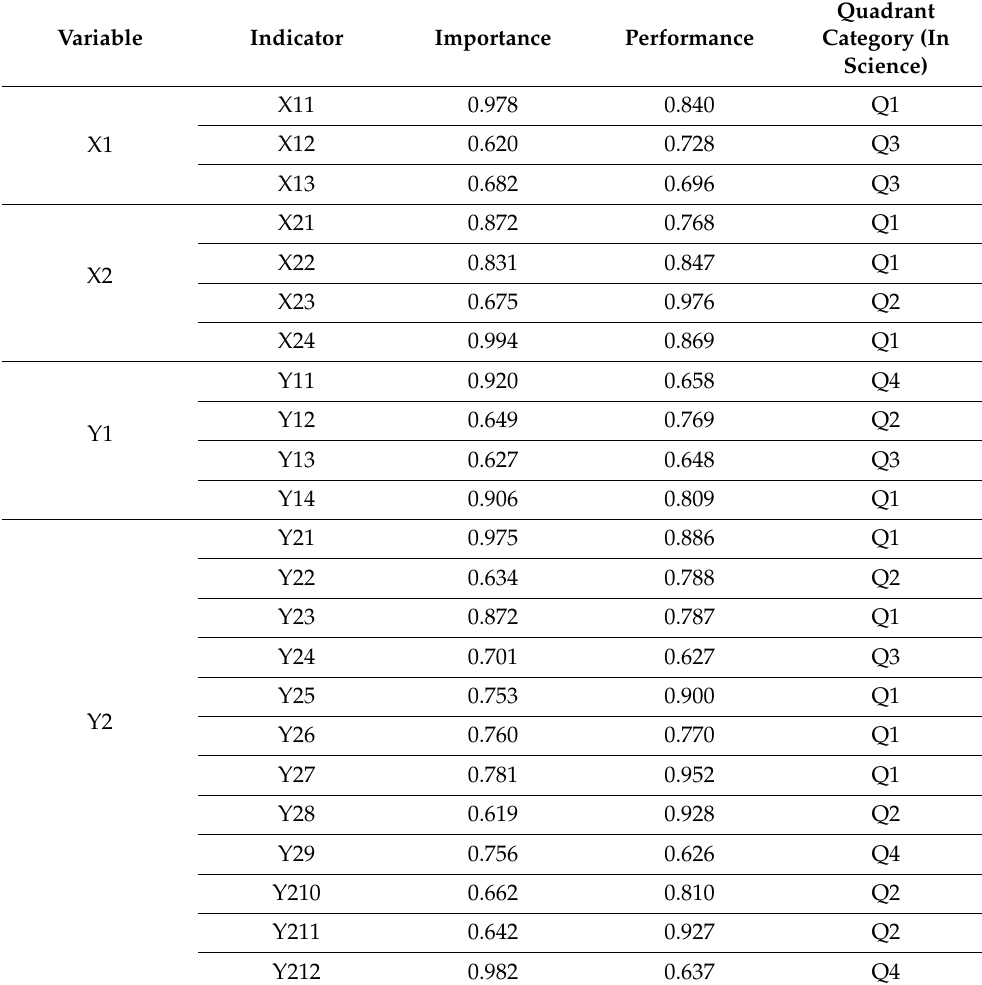
Table 2. IPA Analysis